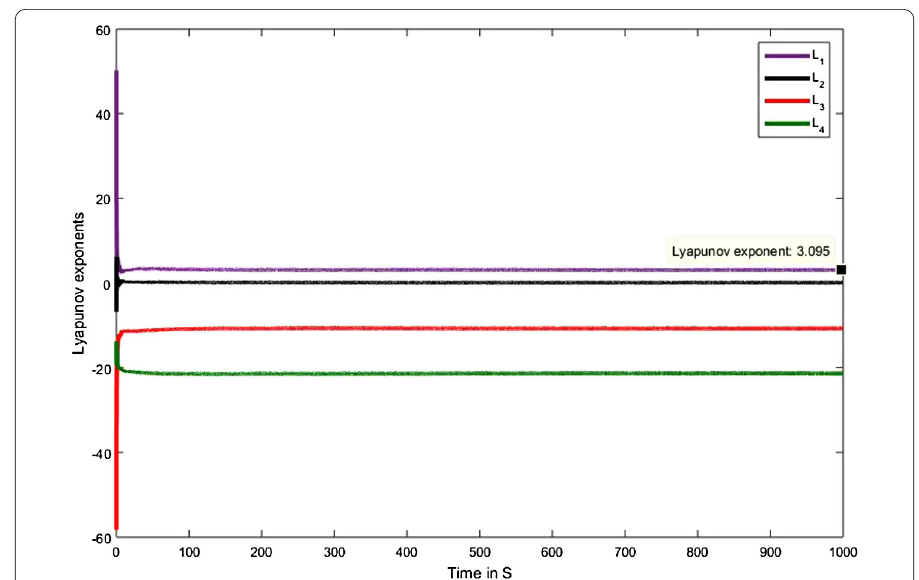
Figure 2 Lyapunov exponents of the fractional-order induction motor